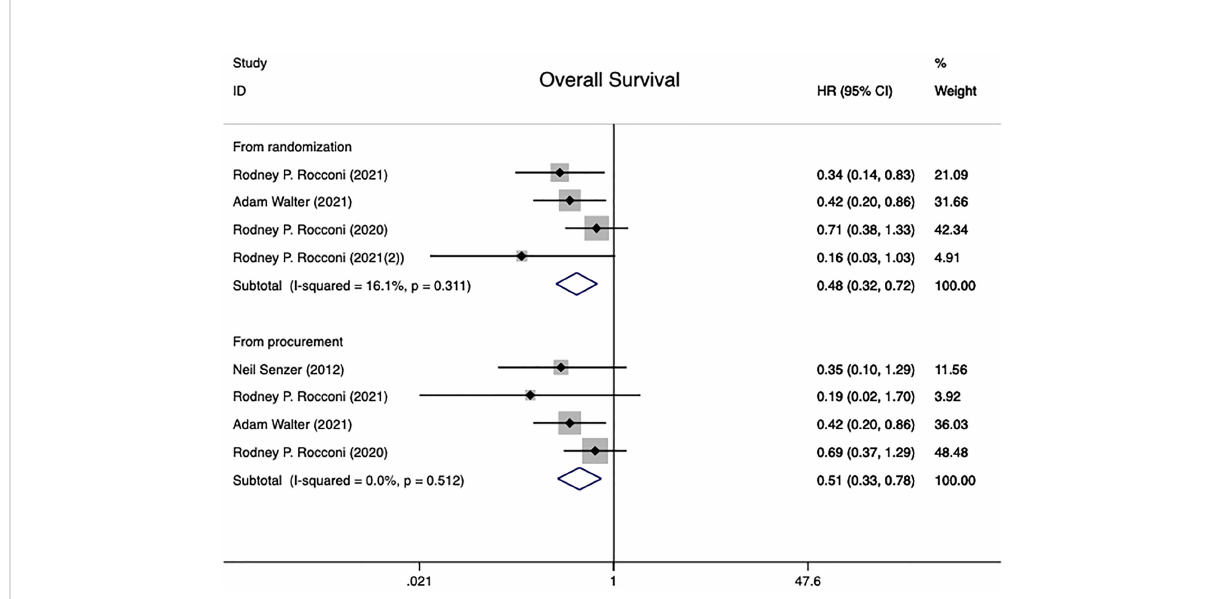
FIGURE 2 Overall survival in advanced OC patients at randomization and from time of tissue procurement time by using a fi xed-effect model. OC, ovarian carcinoma; CI, con fi dence interval; HR, hazard